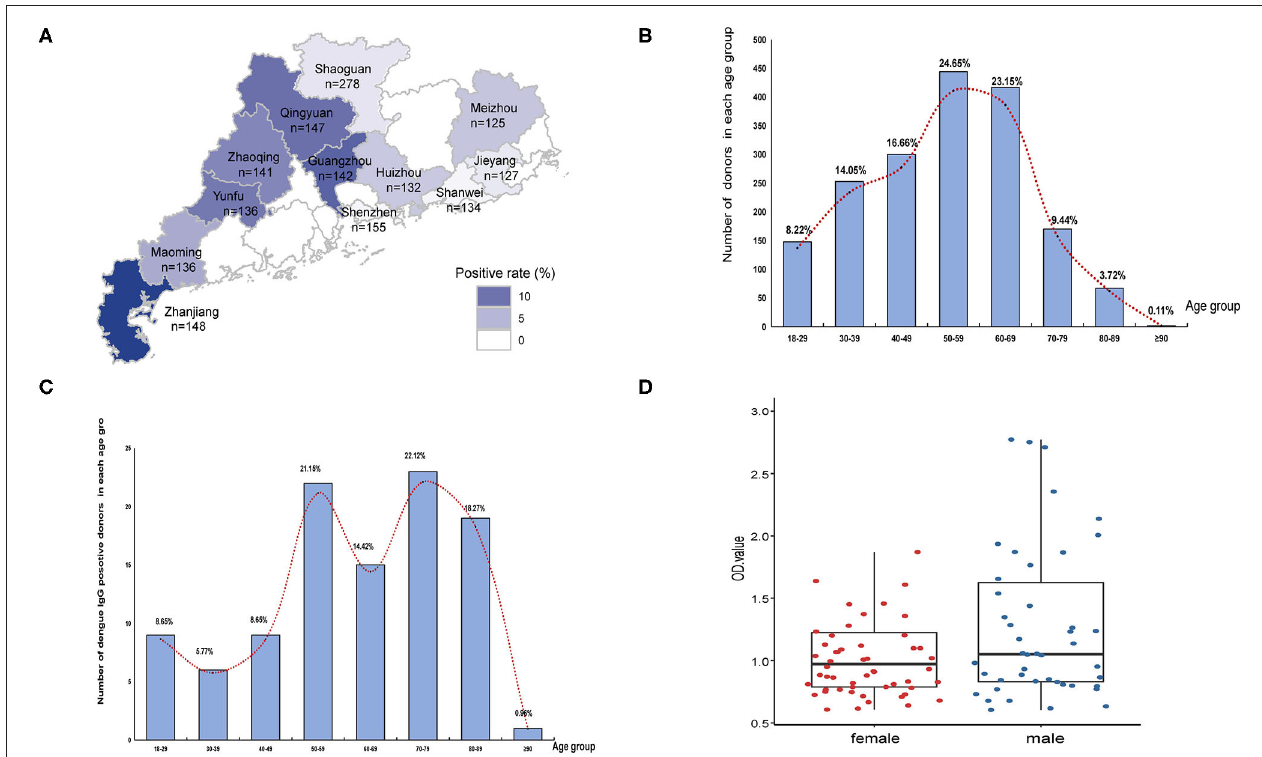
FIGURE 2 | Seropravelence of dengue in Guangdong. (A) Geographic distribution of dengue IgG antibodies positivity rate in 11 cities of Guangdong. The areas with high positivity rates are marked by dark blue. (B) Age distribution of all donors ( n = 1,801). (C) Age distribution of seropositive donors ( n = 104). The distribution is presented by the number of positive donors in each age group. (D) Distribution of seropositive ELISA test data in female and